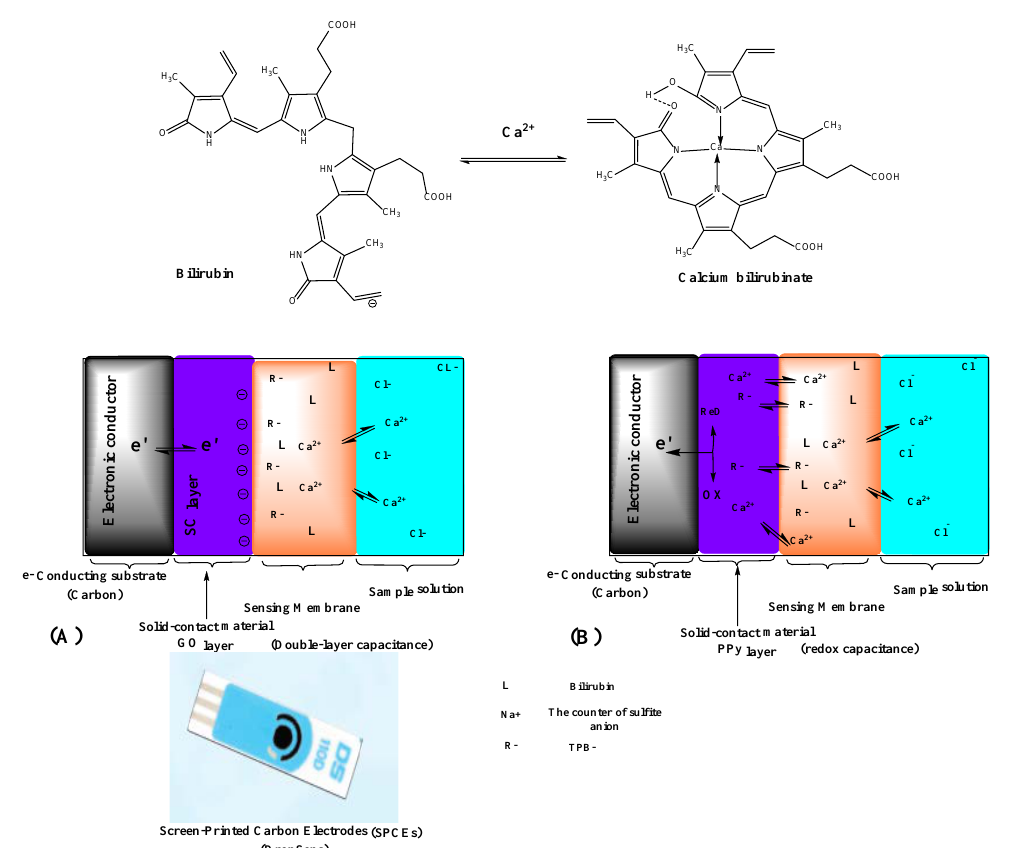
Figure 2. Structure of both bilirubin and calcium bilirubinate complex. ( A ) an SC / ISE with GO layer Figure 2. S tructure of both bilirubin and calcium bilirubinate complex. ( A ) an SC/ISE with GO layer (double-layer capacitance layer) and ( B ) an SC/ISE PPY layer (redox capacitance layer). (double-layer capacitance layer) and ( B ) an SC / ISE PPY layer (redox capacitance